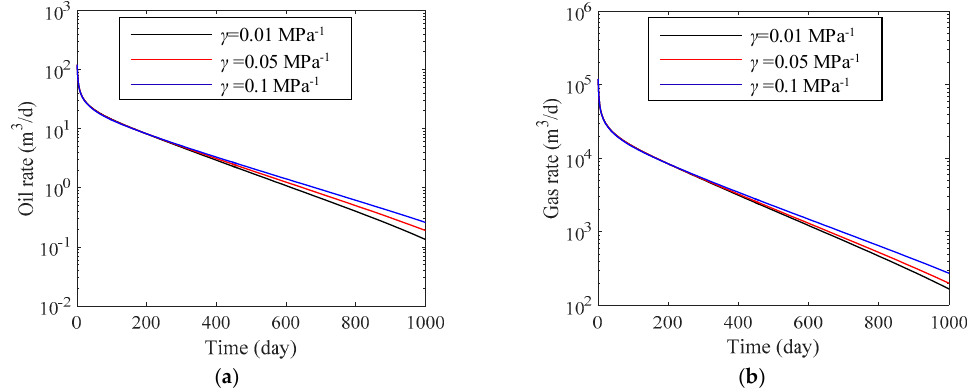
Figure 7. Influence of permeability stress sensitivity of fracture on production rate: ( a ) influence of permeability stress sensitivity on oil production rate; ( b ) influence of permeability stress sensitivity on gas production rate.